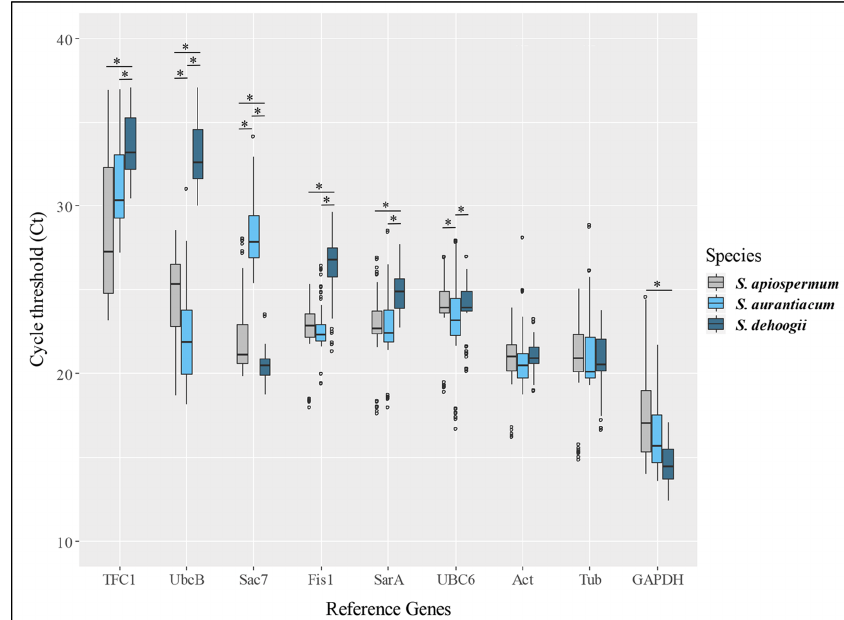
Figure 3. Variations in the expression of several reference genes in the different culture conditions studied. For each gene, an ANOVA–Tukey test was performed to analyze the variations between